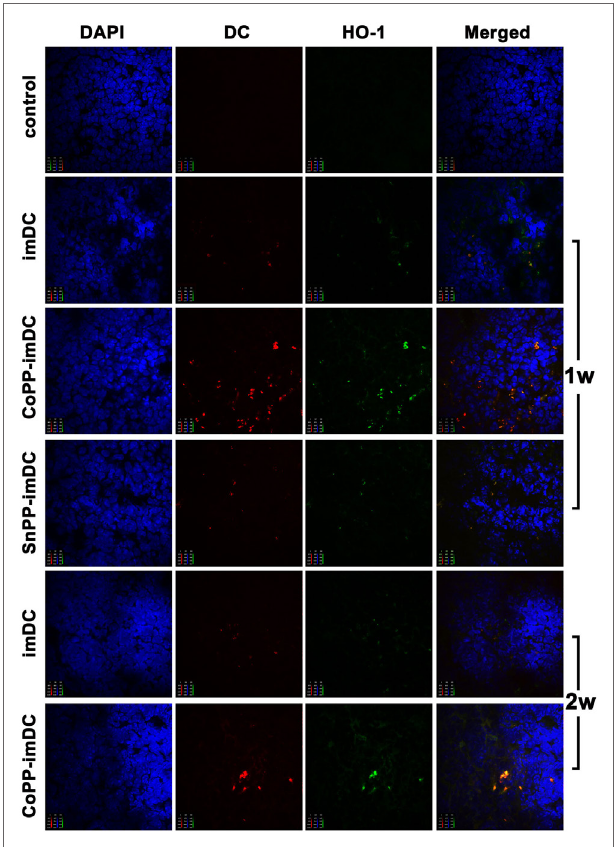
FigUre 6 | The survival of donor-derived dendritic cells in recipient spleen and their expression of heme oxygenase-1 (HO-1) after adoptive transfer. After being labeled with CellVue Claret, untreated, cobalt protoporphyrin- pretreated-, or SnPP-pretreated BALB/c mouse-derived immature dendritic cells (5 × 10 6 ) were injected intravenously into C57BL/6 mice. Seven or 14 days later, the spleens were harvested for immunofluorescent detection of CellVue Claret (red), HO-1 expression (green), and DAPI (red). Representative photographs were captured under a confocal imaging system (magnification, 600 × ; n = 3 per